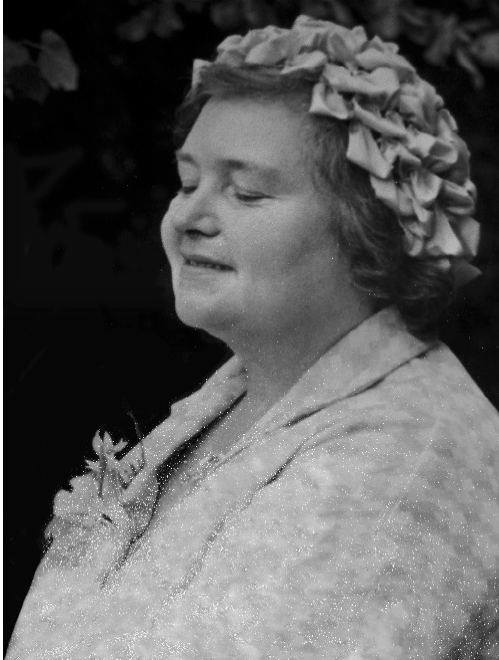
Figure 1. Mary Jones (1917–1981) in 1971 (photograph reproduced with kind permission of the Jones family).